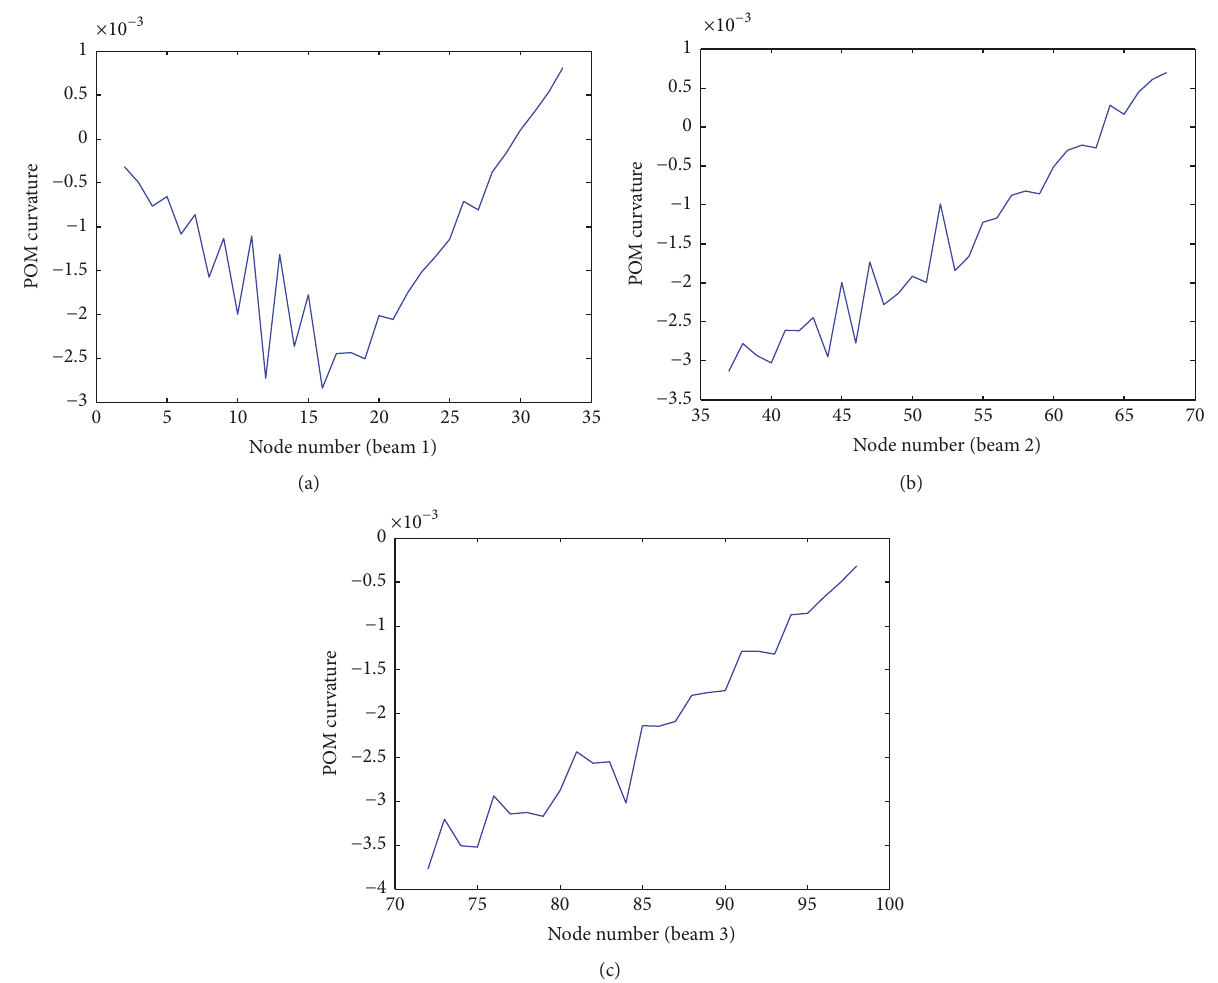
Figure 6: POM curvature curves using FRFs in the region (A) containing 1% external noise: (a) beam 1, (b) beam 2, and (c) beam 3.